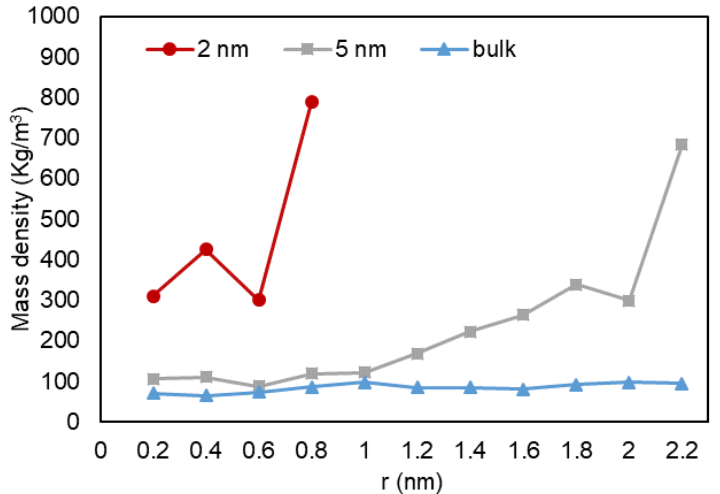
Figure 19. Mass density variation vs. radial position for C2.